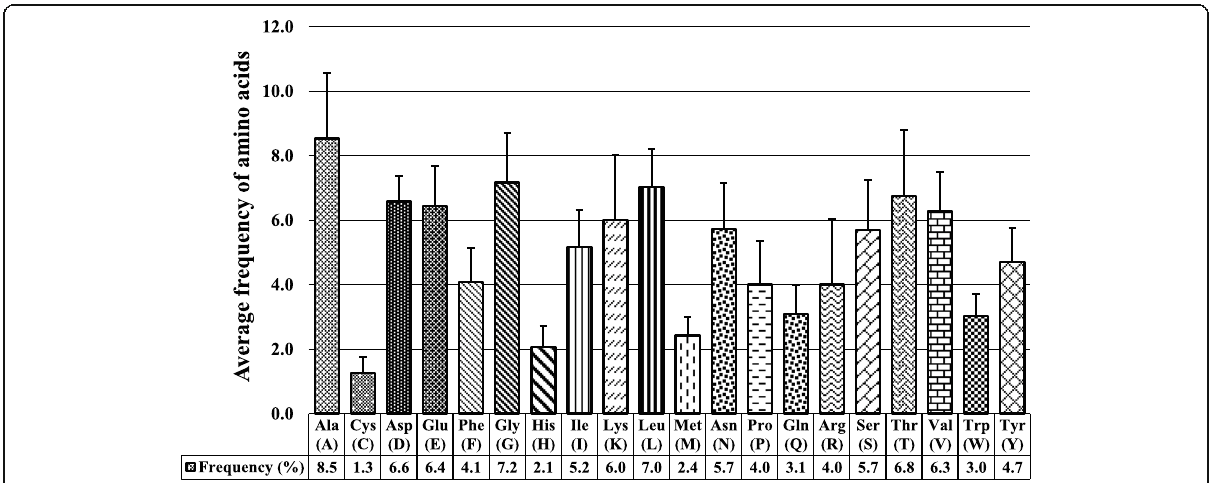
Fig. 3 Amino acid composition of GH5-cellulases family from uncultured microorganisms computed using the CLC workbench 8.1.2